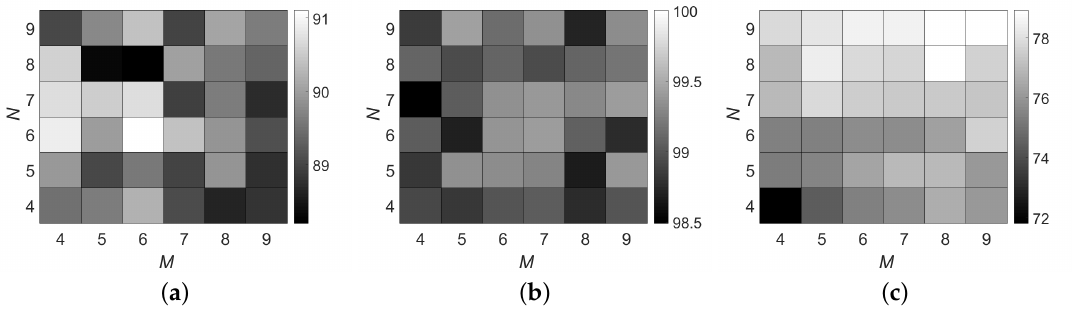
Figure 8. The influence of parameters on OA (%) in H 2 F. Results on ( a ) Indian Pines; ( b ) KSC and ( c ) GRSS_DFC_2014 data sets. M is the number of sub-feature sets, and N is the number of features in each